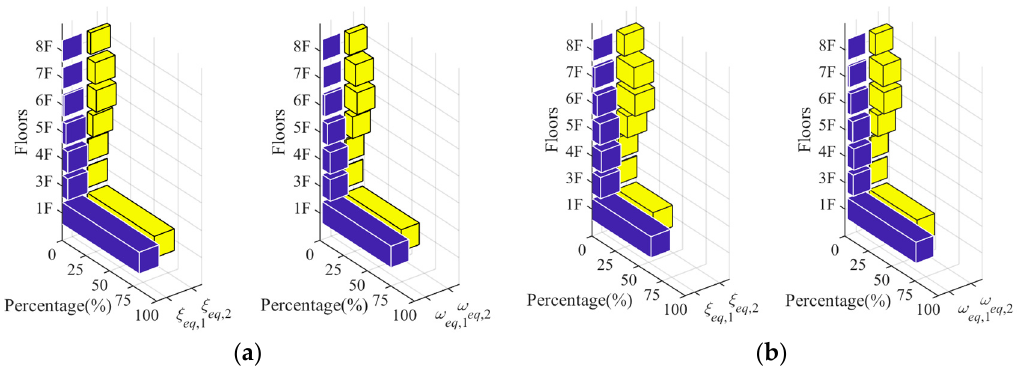
Figure 5. Percentages of the equivalent damping ratios and natural frequencies from oil dampers of same floors: ( a ) Longitudinal direction; ( b ) Transversal direction.